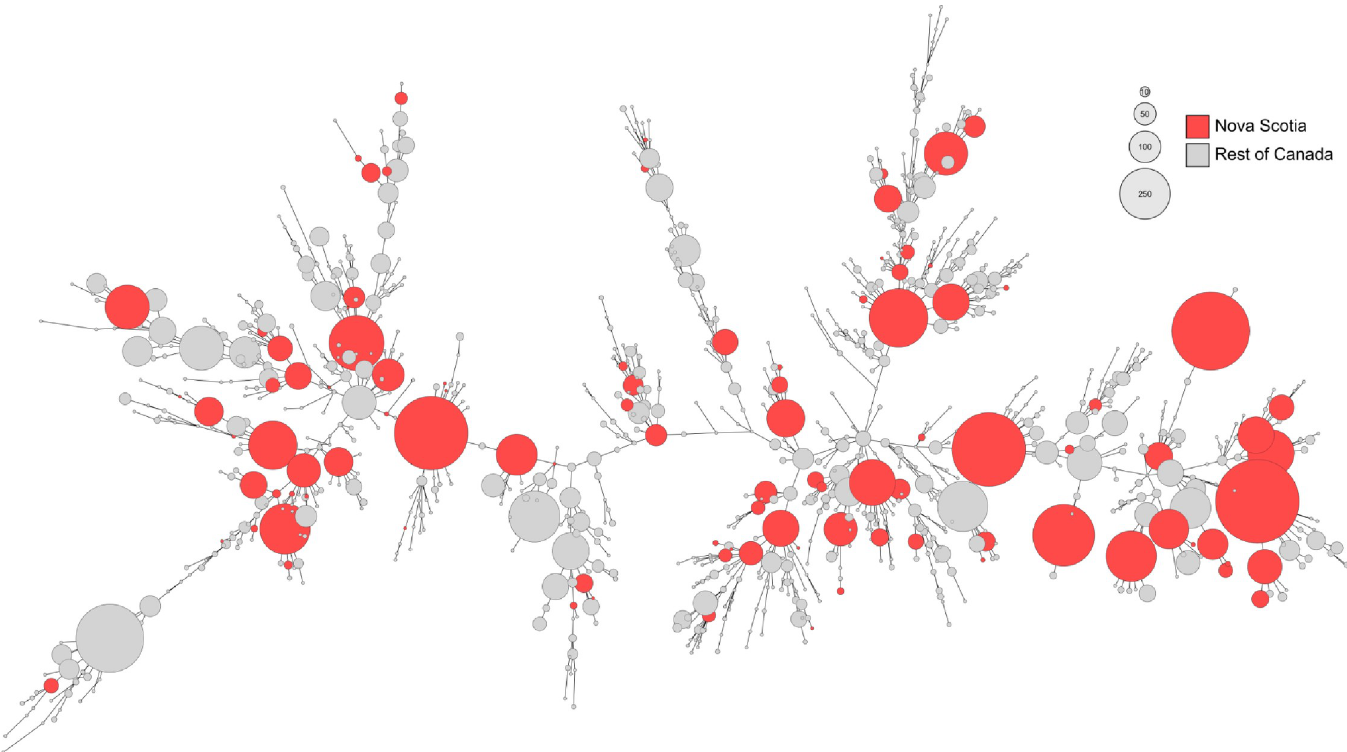
Fig 2. Population structure of Canadian chicken-associated C . jejuni . A minimum spanning tree of all CGF subtypes found in the C3GFdb which have been isolated from chicken; red circles represent subtypes from both Canada and this study, grey circles represent subtypes which were not recovered from chicken in this study. Node sizes are scaled based on the aggregate number of isolates in this study and the